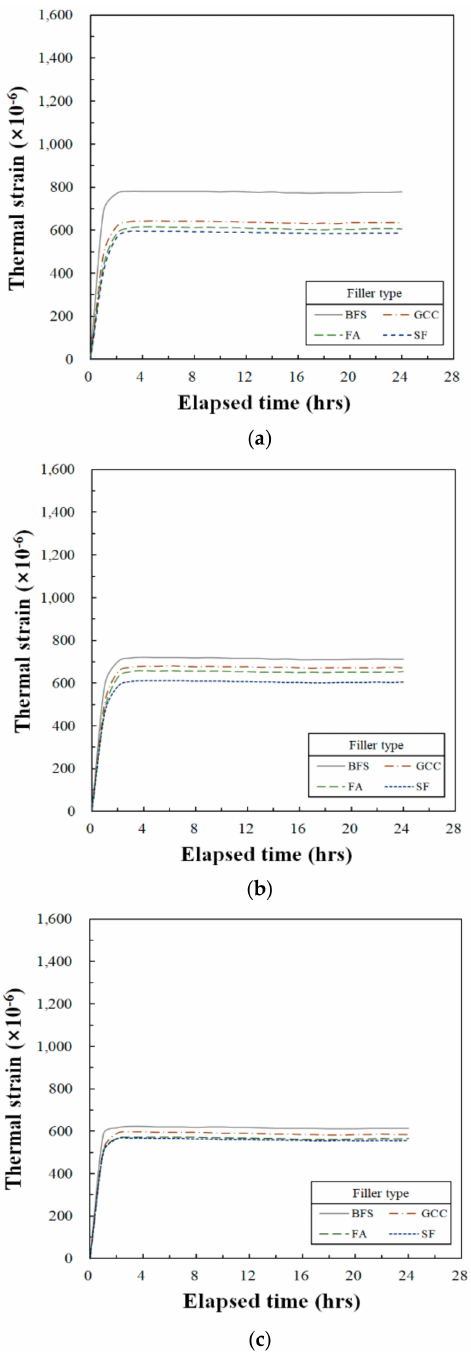
Figure 5. Variation of thermal strain as function of elapsed time for type of filler: ( a ) SRA content is 0%; ( b ) SRA content is 10%; ( c ) SRA content is